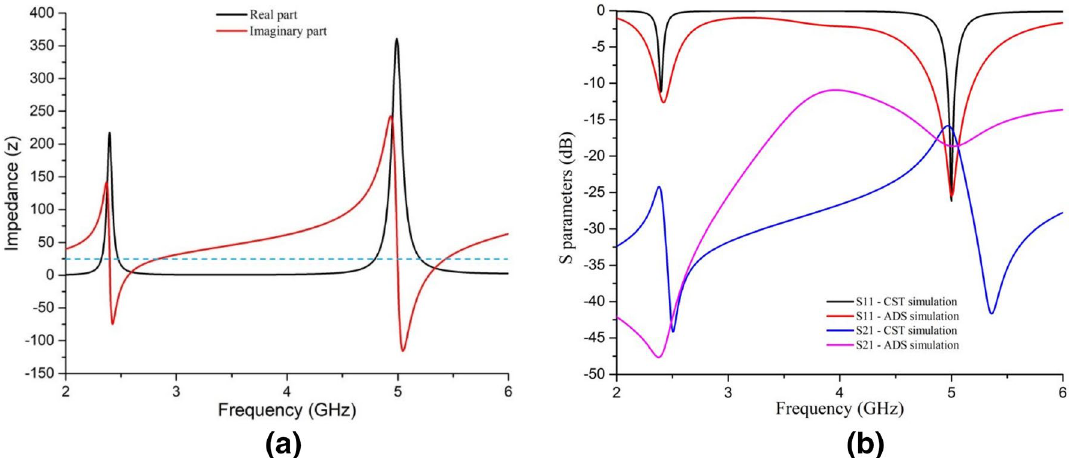
Figure 5. ( a ) impedance of the unit cell at operating frequencies and ( b ) S parameters with less than − 10 dB values achieved by equivalent circuit and CST simulation.